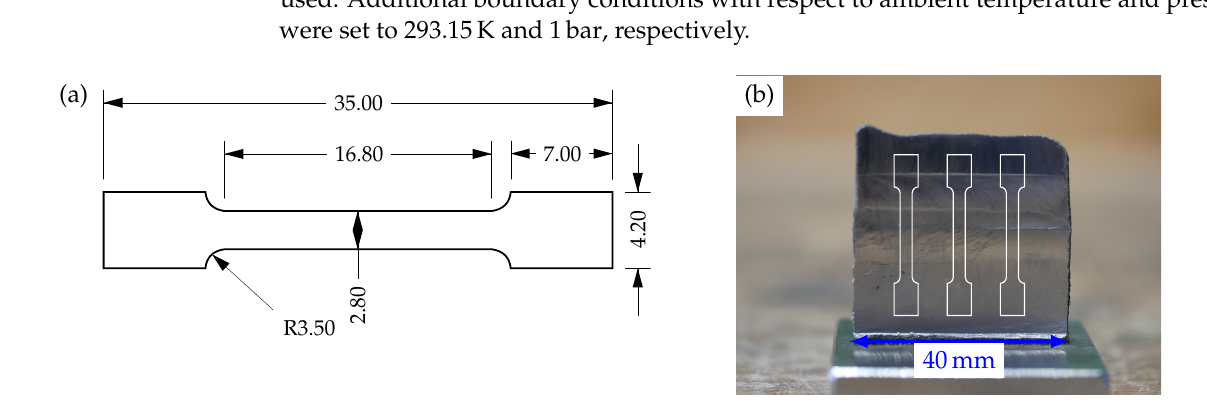
Figure 3. ( a ) Specimen geometry used for tensile testing, adopted from [34]. Dimensions in millimeter; ( b ) location of tensile testing specimens within the structures manufactured by laser-based DED. Depicted is as-milled surface condition.